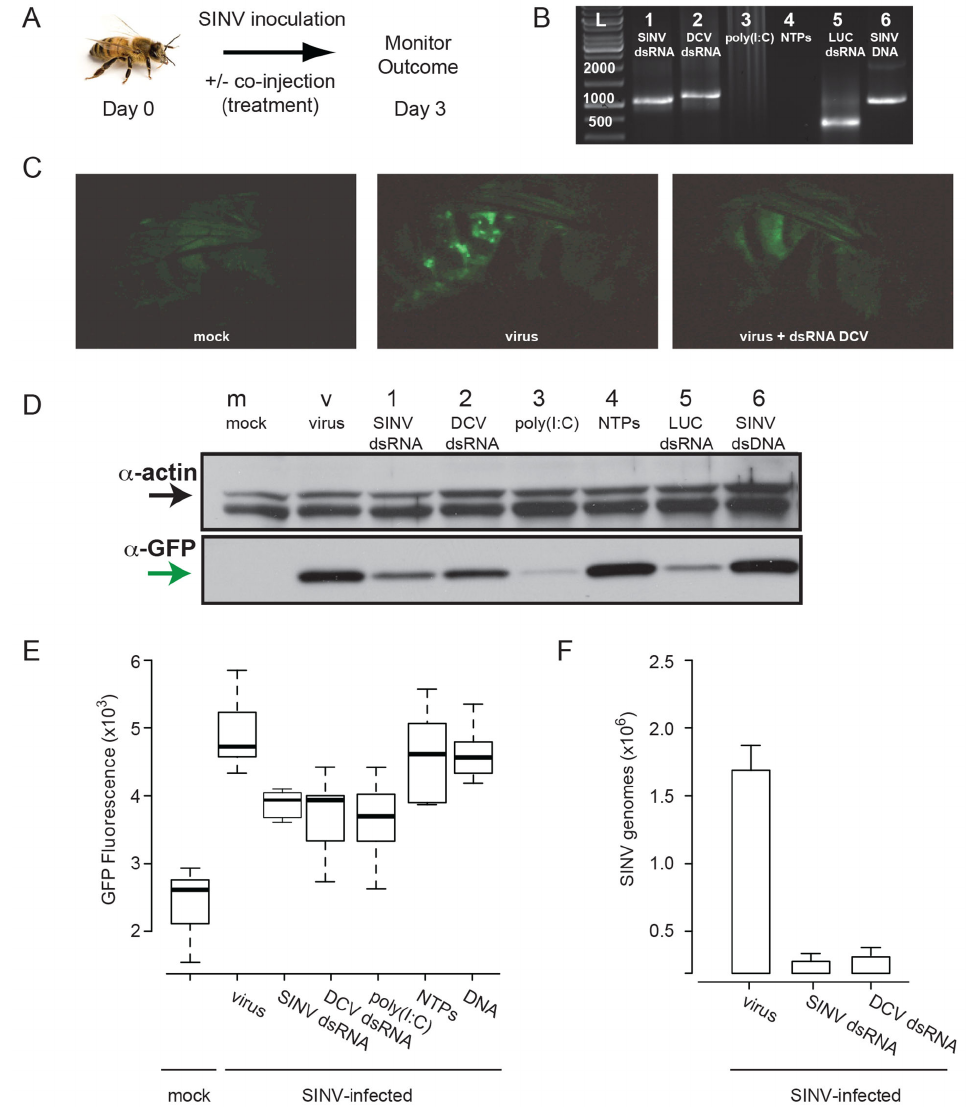
Figure 2. dsRNA-mediated reduction of virus in honey bees. (A) Schematic of experiment. Honey bees were inoculated with SINV-GFP or co-injected with (B) nucleic acid treatments including: virus-specific dsRNA (SINV dsRNA); non-specific dsRNA corresponding to Drosophila C virus (DCV) sequence (DCV dsRNA); poly(I:C); NTPs; non-specific dsRNA corresponding to luciferase sequence (LUC dsRNA); or SINV dsDNA visualized on a 1% agarose gel. (C) Fluorescence microscope images of a mock-infected bee (left panel), a SINV-GFP infected bee (middle panel), or a bee infected with SINV-GFP in the presence of non- specific dsRNA DCV. (D) Western blot analysis using α-GFP and α-actin antibodies demonstrated reduced SINV-GFP in bee protein lysates pooled from ten bees treated with dsRNA (lanes 1, 2, and 5) and poly(I:C) (lane 3), but not in bees treated with NTPs (lane 4) or dsDNA (lane 6) compared to bees inoculated with virus alone (virus). Mock-infected (mock) bees injected with buffer had no detectable GFP. (E) Boxplot of GFP fluorescence (510 nm, relative arbitrary units) in individual honey bee lysates (10 bees per condition). A Welch two-sample t-test was performed to compare honey bee lysates from each treatment group to virus-infected bees and determined statistically significant differences between bees co-inoculated with virus-specific dsRNA SINV p=0.023, with non-specific dsRNA DCV p=0.020, and with poly(I:C) p=0.0038, whereas co-injection of NTPs p=0.41 or dsDNA p=0.36 were not significantly different from virus alone (virus). Bees injected with virus only (virus) exhibited greater fluorescence compared to mock- infected controls (m); p=0.00001. (F) Relative abundance of SINV-GFP in individual bees (5 per condition) from different treatment groups was assessed by RT-qPCR. The bees treated with virus only had the highest SINV copy number 3 days p.i. (1.65x10 6 copies + 4,100 copies per 500 ng RNA, ~1.65x10 8 per bee), as compared to those in which either virus-specific SINV dsRNA (1.66x10 5 +1,050) or non-specific DCV dsRNA (2.32x10 5 + 1,070) was co-injected with virus. doi: 10.1371/journal.pone.0077263.g002 PLOS ONE |